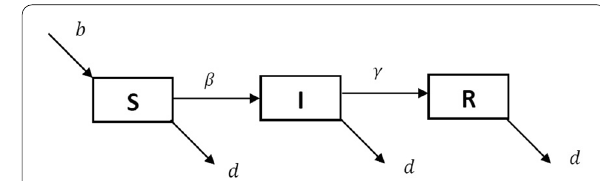
Fig. 3 Compartmental structure of SIR model with vital dynamics